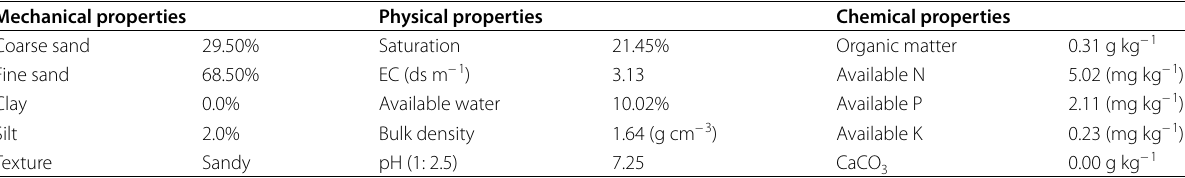
Table 1 Mechanical, physical, and chemical properties of sand soil used in the present study Mechanical properties